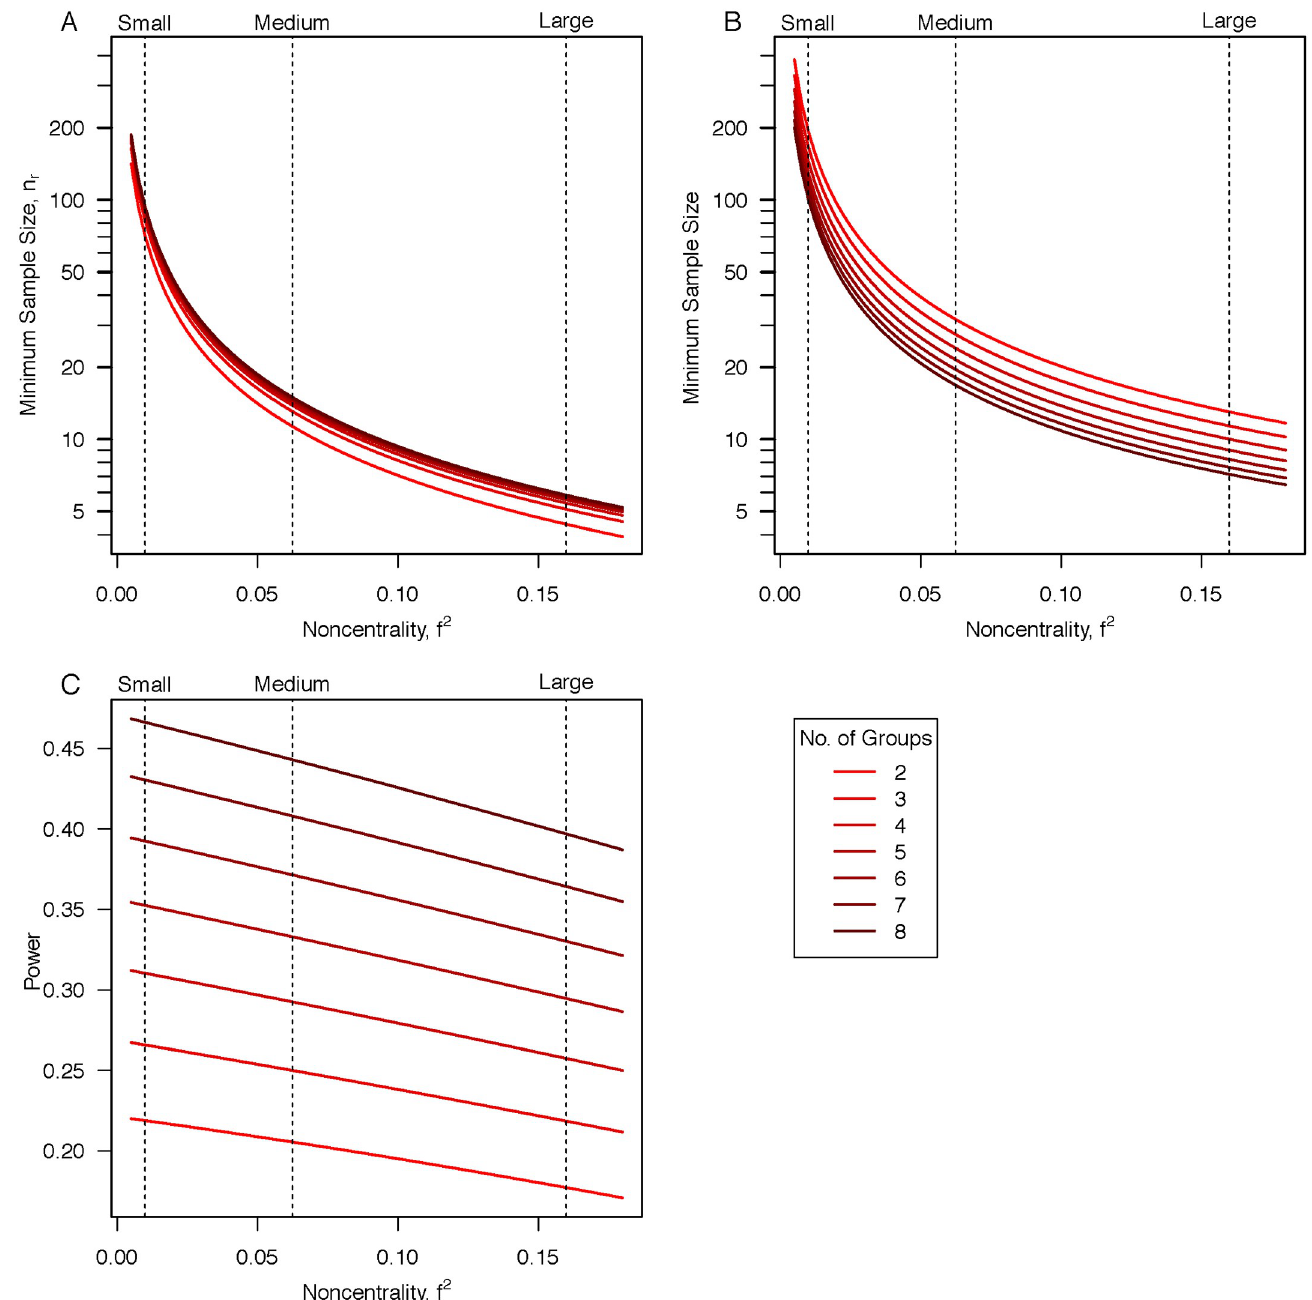
Fig 4. A . Minimum sample size (per condition) for minimal acceptable accuracy of the sample mean as a function of effect size f 2 and the number of conditions. One of the more noteworthy aspects is that the needed sample size per condition increases with the number of conditions. B . Minimum sample size (per condition) for a power of 50% at the 5% level. The needed sample size per condition decreases with the number of conditions. C . The power at the 5% level for the minimum sample size for minimal sample mean accuracy. Surprisingly, commonly powered designs often yield unacceptably accurate sample means.